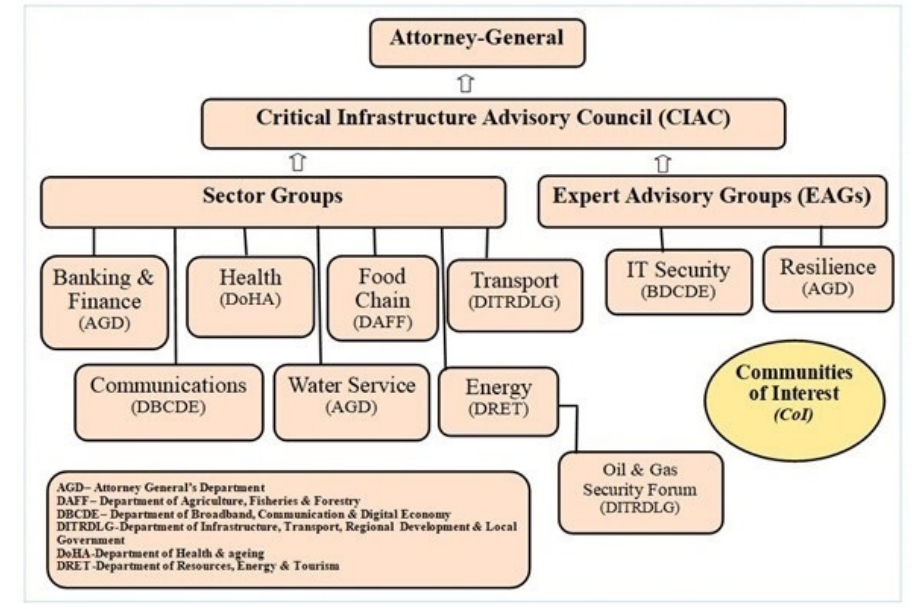
Figure 2. The Australian government’s structure for the Trusted Information Sharing Network (TISN) [39].